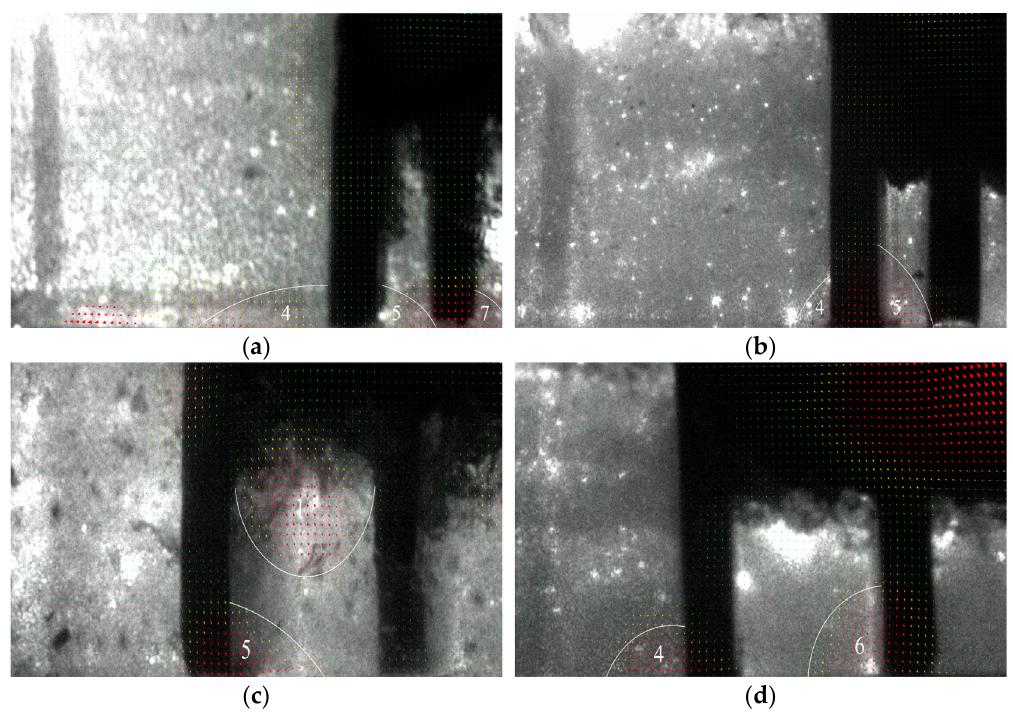
Figure 14. ( a ) X − direction contour diagram and ( b ) Y − direction contour diagram of soil displace- ment for MP − 15 model.